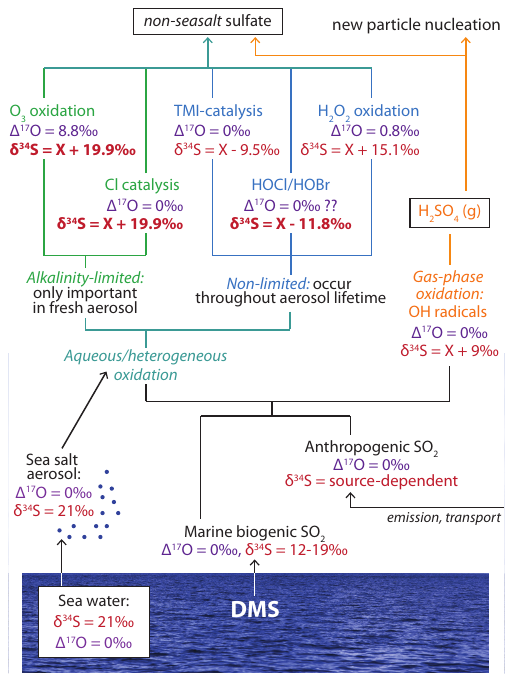
Fig. 6. Summary of the SO 2 oxidation reactions occurring in the marine boundary layer and their effect on the isotopic composition of product sulfate. Initial isotopic compositions of sea water and marine biogenic sulfate are from Rees et al. (1978) and Calhoun et al. (1991) respectively. 1 17 O values refer to the sulfate resulting from oxidation, not the oxidant itself, and are from Savarino et al. (2000). δ 34 S fractionations during oxidation reactions are shown as a change, where X is the δ 34 S of the SO 2 reactant gas. Fractionation factors are for 19 ◦ C; those measured in this study are shown in bold and all other 34 S/ 32 S fractionations are from Harris et al.